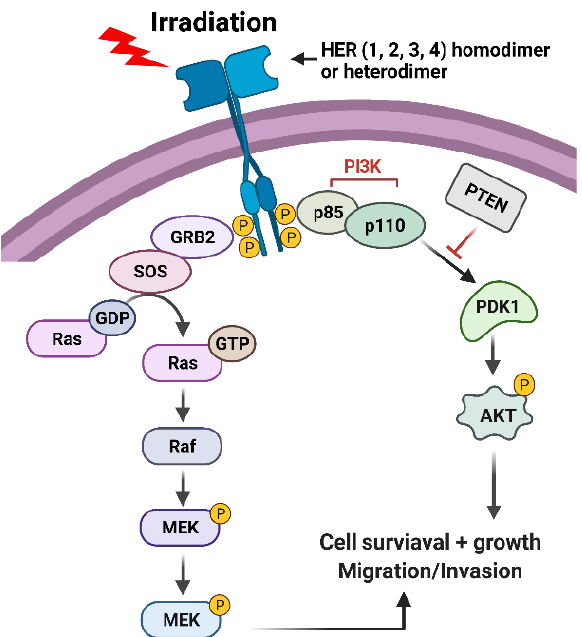
Figure 3. Radiation induces activation of HER receptors, which, in turn, leads to the activation of PI3K/AKT and RAS/RAF/MEK/ERK signaling pathways that promote cell survival. PI3K/AKT and RAS/RAF/MEK/ERK signaling pathways that promote cell